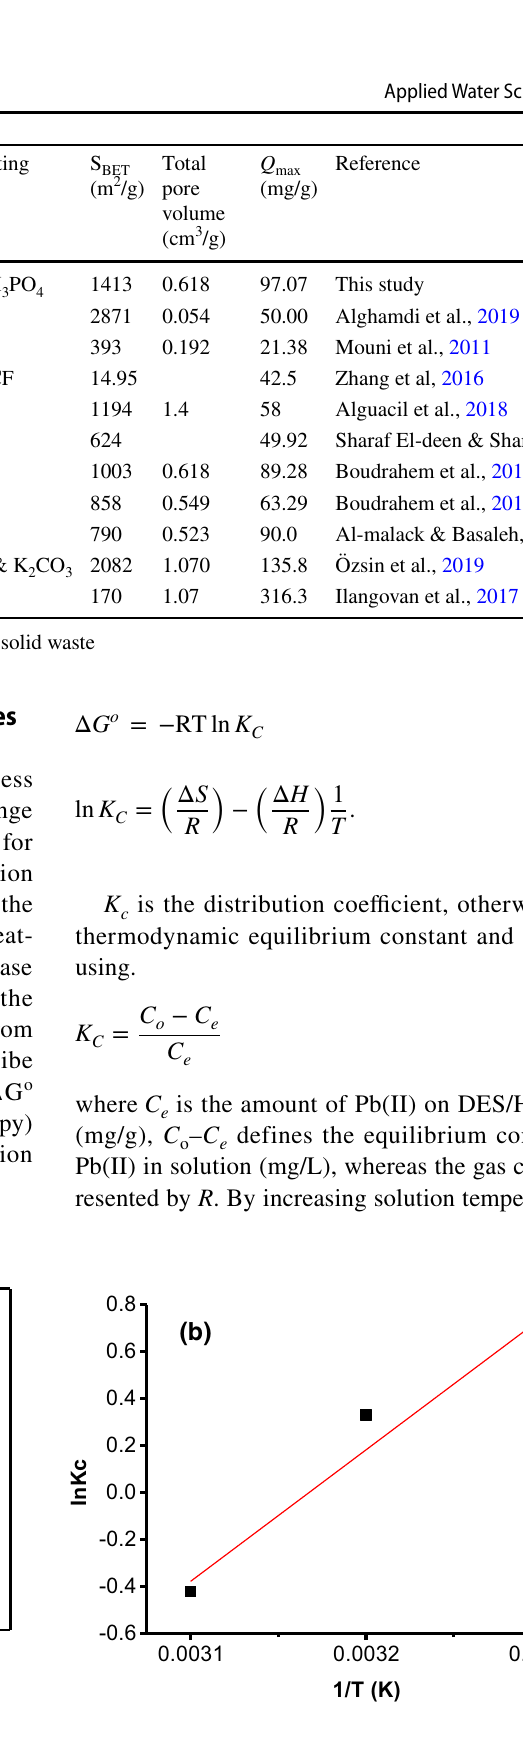
Fig. 9 a Adsorption of Pb(II) by DES/H 3 PO 4 -600 2:3 as a function of temperature, b Vant Hoff’s plot.(dosage = 0.2 g/L, time = 140 min, [Pb] o = 125 mg/L, pH =